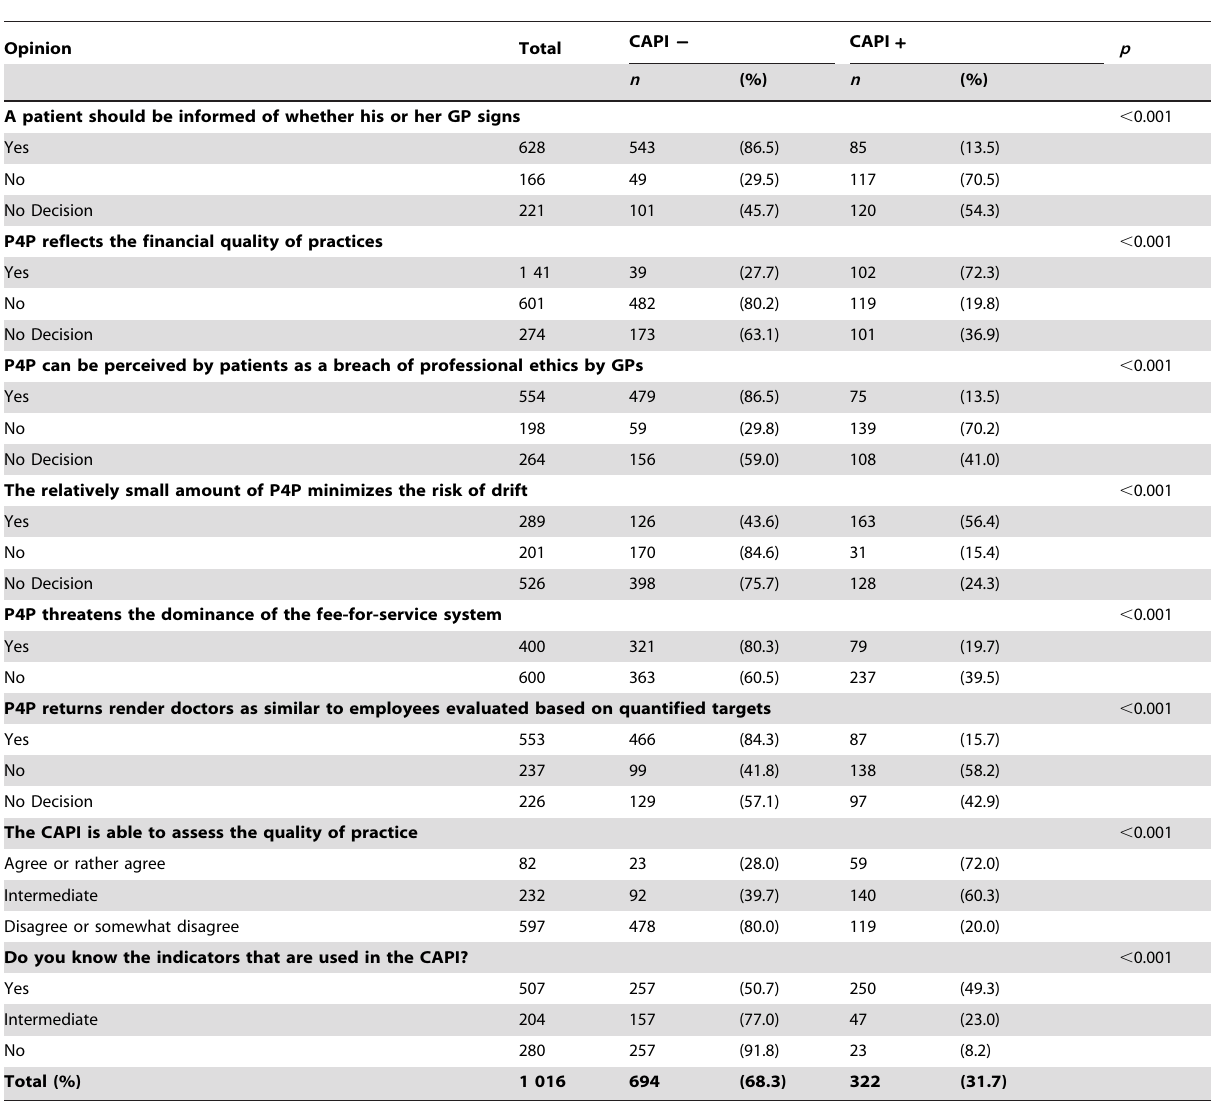
Table 3. Relationship between the CAPI subscription and opinions regarding this